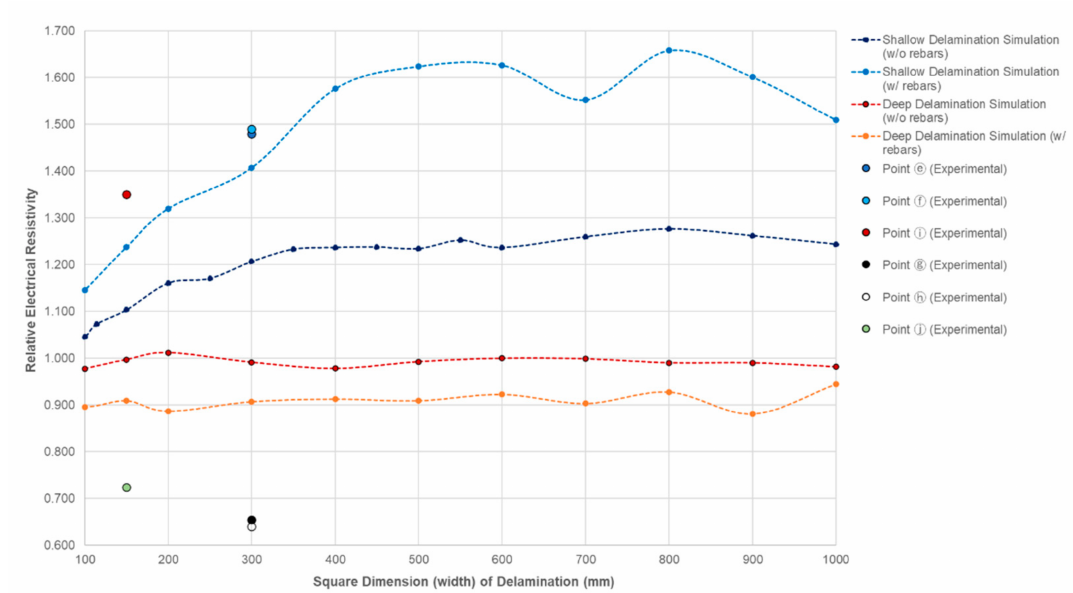
Figure 10. Variation of the relative electrical resistivity of concrete slab with varying lateral sizes of delamination